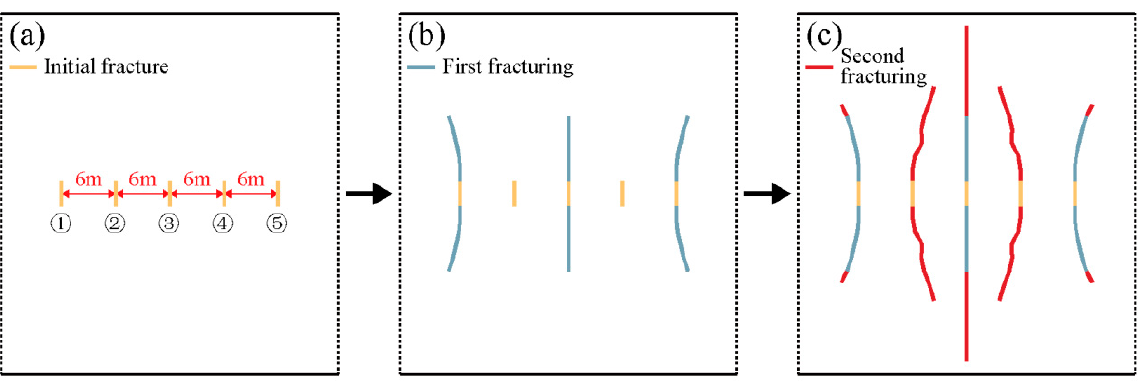
Figure 9. Secondary fracturing results. ( a ) Perforation diagram. ( b ) Fracture path after first fracturing. ( c ) Fracture path after the second fracturing.